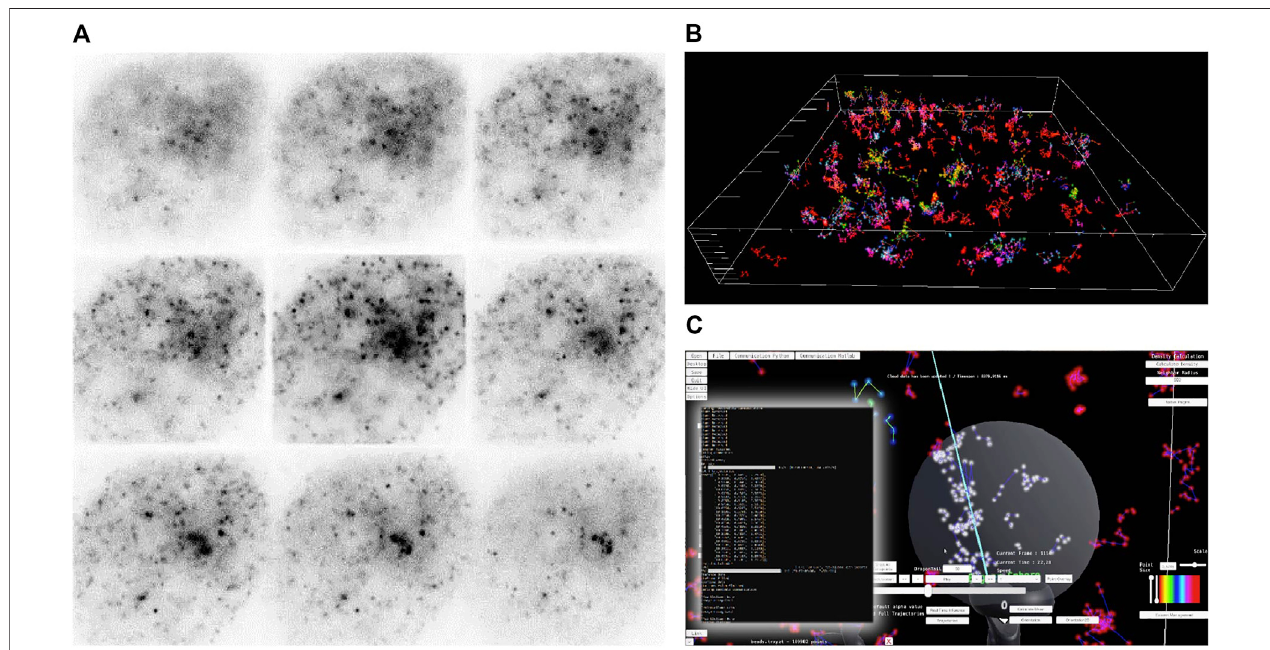
FIGURE 2 | Work fl ow for single-molecule analysis in Genuage. (A) Raw images of diffusing particles in the nucleus of a cell are captured with MFM. Images are analyzed, and a table is generated containing the position of each particle and the corresponding timestamp. (B) The localizations are imported into Genuage and explored in VR. Color codes can be tuned to represent individual trajectories or the temporal evolution of the point cloud dynamics. (C) A screenshot of the Genuage interface as a selection of point cloud subsets and analysis is performed. Trajectory selection is performed using the VR controllers with a visual aid in the form of a sphere.Othershapescanbeusedtoselectpoints.Inhighlyconvolutedpointdistributions,theusercande fi nelandmarksgeneratingaconvexhullthatwillcapturepoints of interest. Results are displayed as changes of the trajectory colors, with intensity depending on the value of the sub-diffusive exponent. The inference analysis is performed in real-time on the selected trajectories (inset shows real-time calculation performed). Various means to display results are available. The screenshot also shows the interface in the current version of the Genuage software. Most of the buttons and displays are self-explanatory [an introduction to the design can be found in the videos associated with (Blanc et al.,